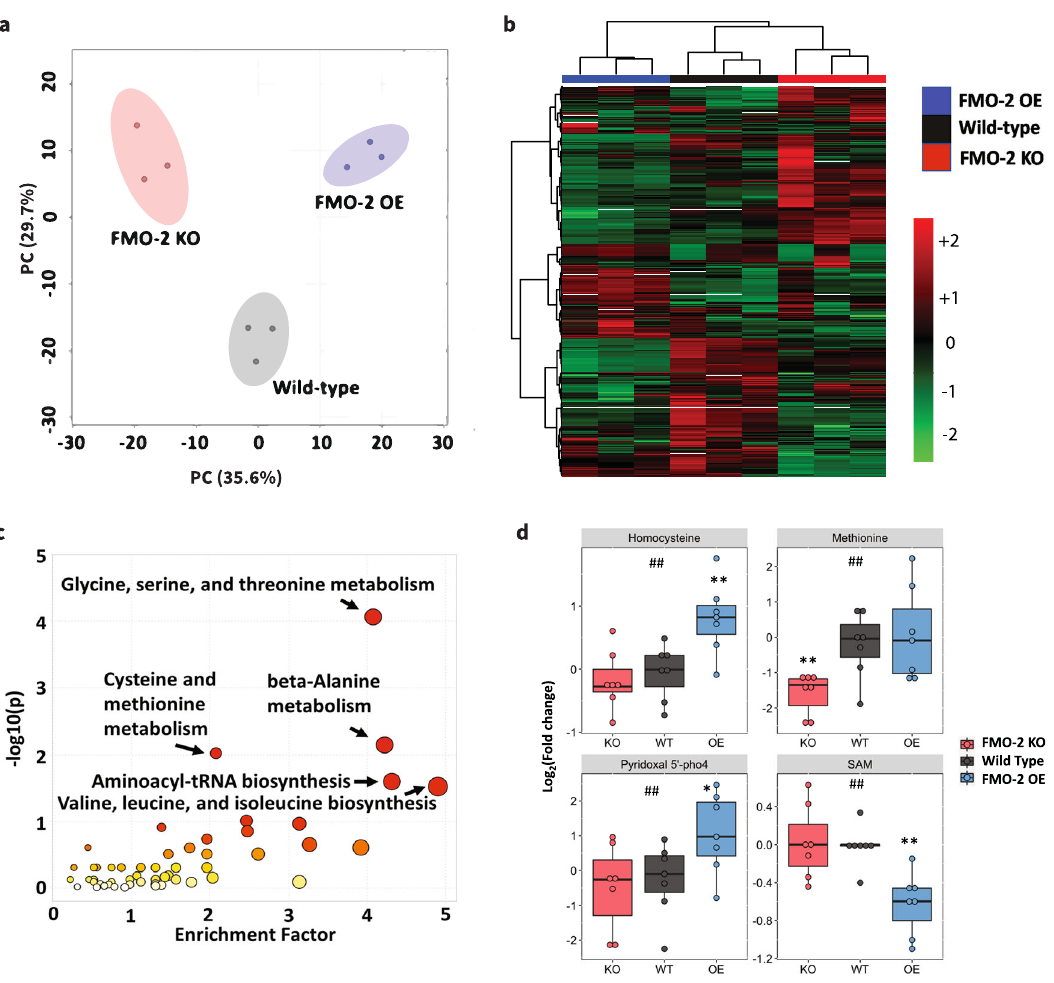
Fig. 1 | One carbon metabolism is altered by fmo-2 expression level. a Principal lower abundance. c Pathway enrichment analysis using untargeted LC-MS metabo- lomics data of wild type and FMO-2 OE. The size and the color of the bubbles represent the enrichment factor and the p -value respectively for the pathways. The darker the color, the more signi fi cant the p -value. And larger the radius of the bubble, the greater the enrichment score. d Comparison of targeted metabolomics dataofmetabolites relatedtoOCMbetweenthewild type(black), FMO-2OE(blue), and FMO-2 KO (red), normalized to the average of wild type intensity. pho4 =